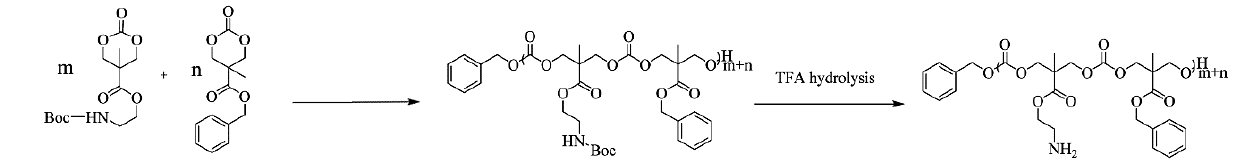
Figure 17. Synthesis of polycarbonates with pending amine groups.